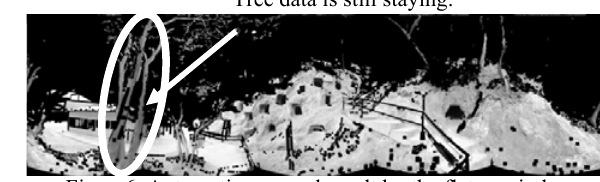
Figure6. Automatic removal result by the flatness index